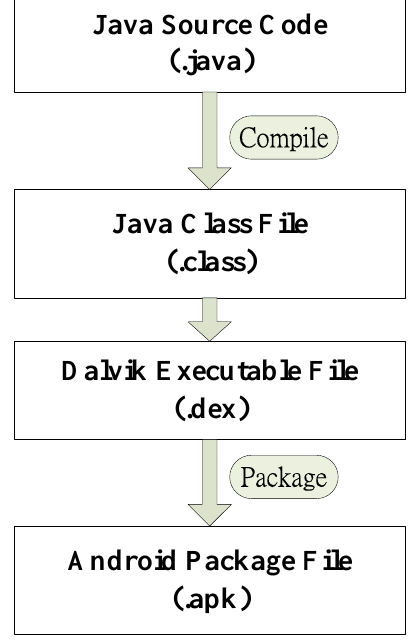
Figure 5. The application program developing process.